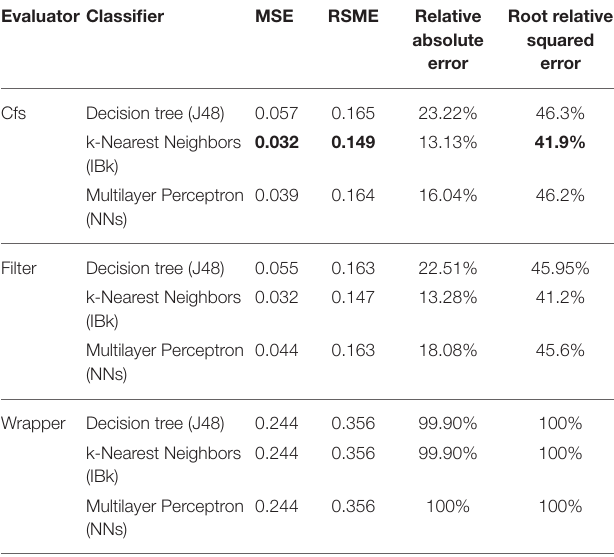
TABLE 3 | Errors of classifying Ads dataset using different classifiers and attribute selection methods.